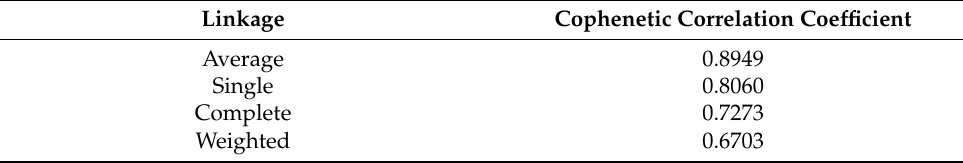
Table 4. Cophenetic correlation